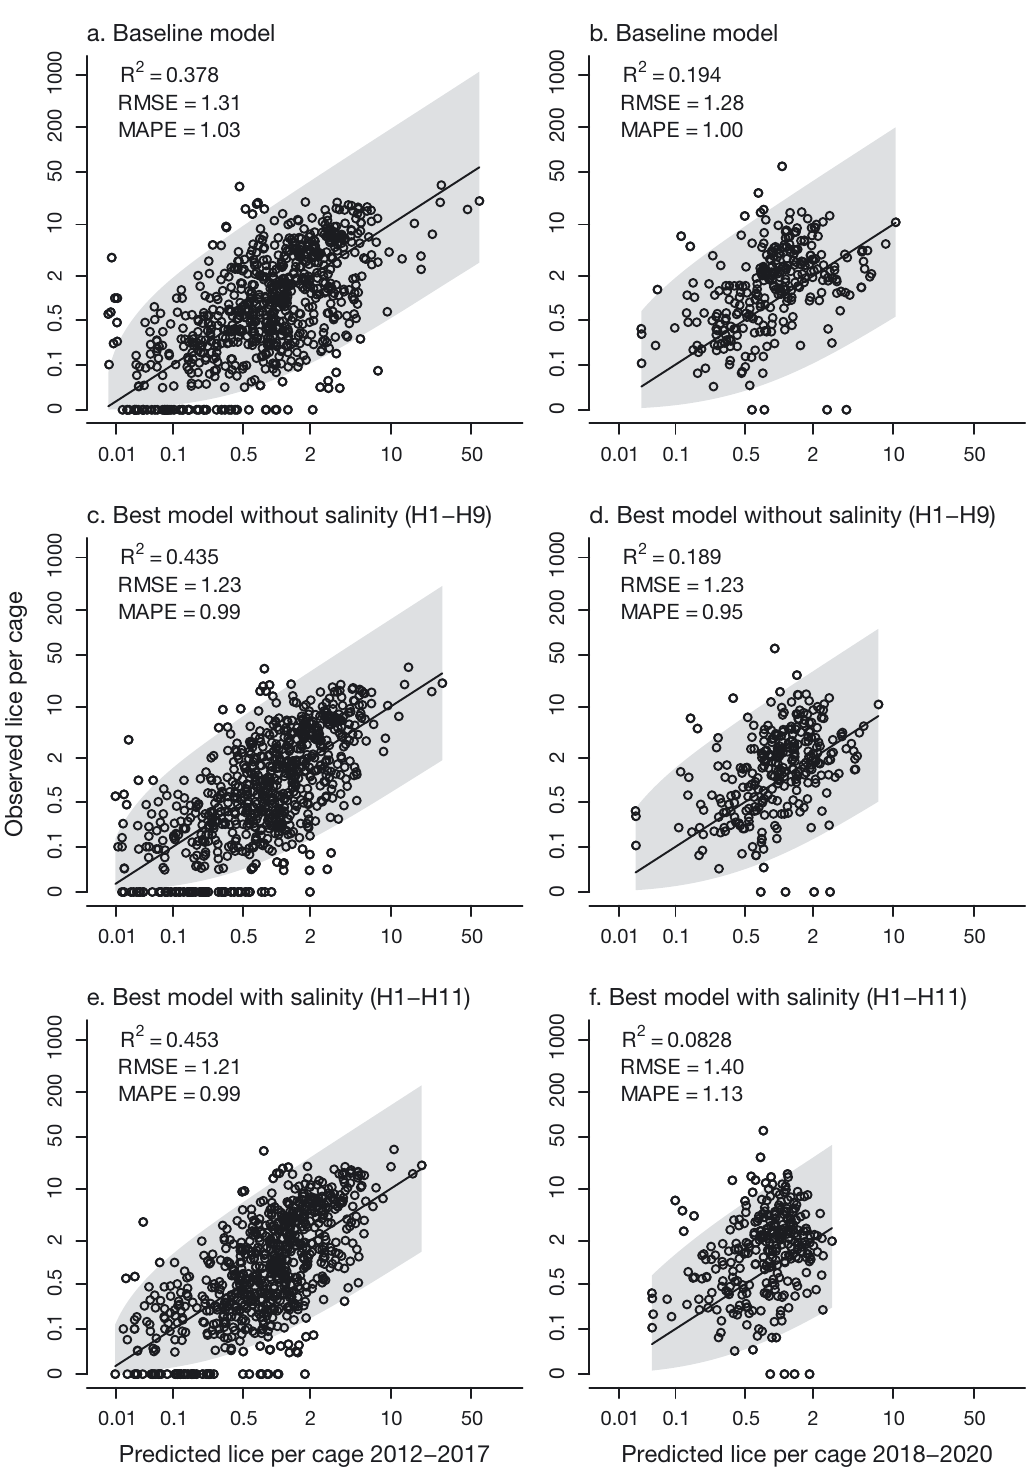
Fig. 8. Within-sample and out-of-sample predictions for alternative ways to calculate salmon lice infestation pressure. (a,b) Baseline model; (c,d) best model without salinity (with H1 ‒ H9 implemented or not as indicated by asterisks in Table 1); (e,f) best model with salinity (H1 ‒ H11). The model formulation was selected using data for 2012 ‒ 2017 and out-of-sample predic- tions were made for 2018 ‒ 2020. Grey bands: 95% prediction intervals. Variance explained (R 2 ), root-mean-squared prediction error (RMSE) and mean absolute prediction error (MAPE) were calculated at the scale ln(lice per cage +